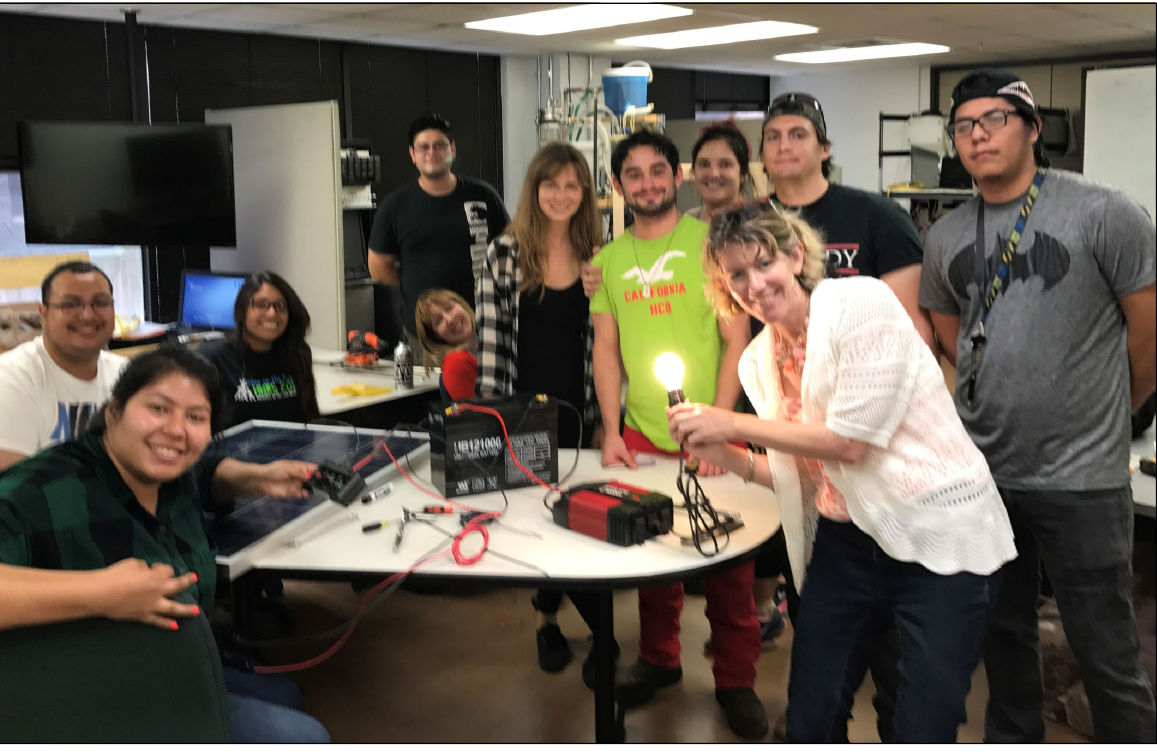
Figure 1. Photo of 2017 Program Participants Clockwise from front left: Jennifer Herrera, Jonathan Garcia, Yarmilla Reyes, Brayan Calvo, Sara Lyons, Andrea Hain, Isaias Gonzalez, Sarah Graeber, Glen Wood, Sergio Diaz, and Lisa